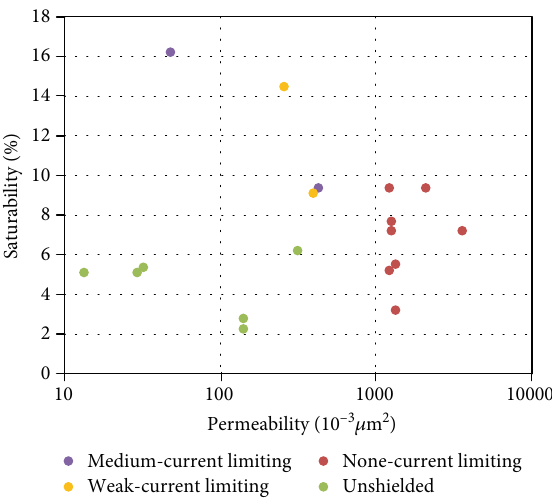
Figure 20: Scatter plot of saturability as a function of permeability of di ff erent fl ow units.